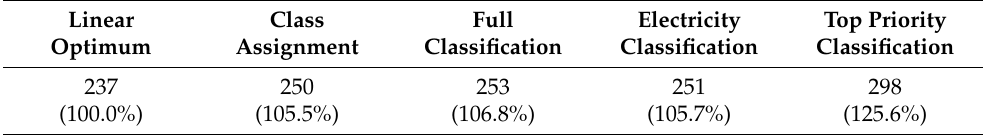
Table 5. Average emissions for one year of simulation and optimisation on emissions (in kg/MWh). Linear Class Full Electricity Top Priority